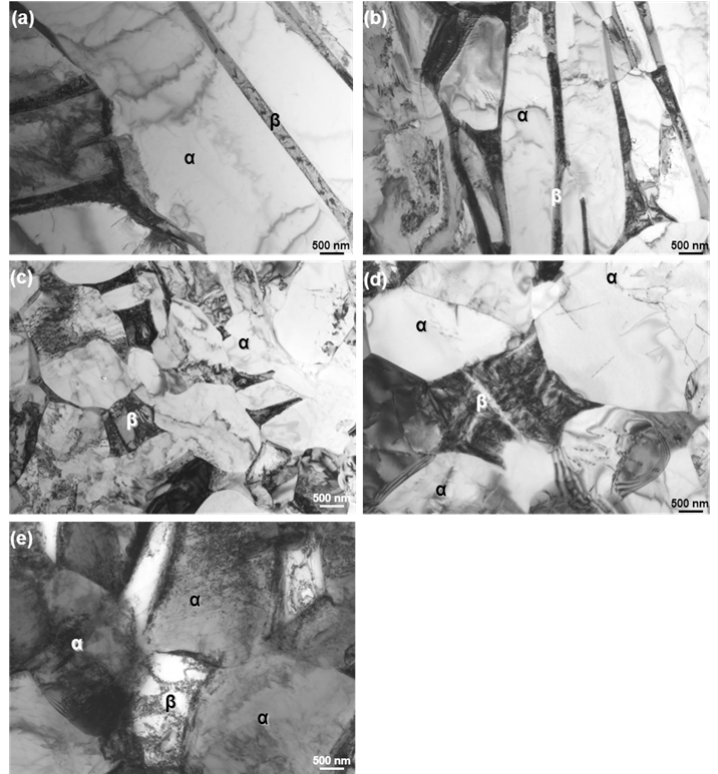
Figure 8. TEM images of ( a–c ) forged Ti-15Zr-4Nb-4Ta alloy A; and ( d ) Ti-15Zr-4Nb-4Ta annealed at 700 °C for 2 h; and ( e ) Ti-6Al-4V annealed alloy at 700 °C for 2 h;